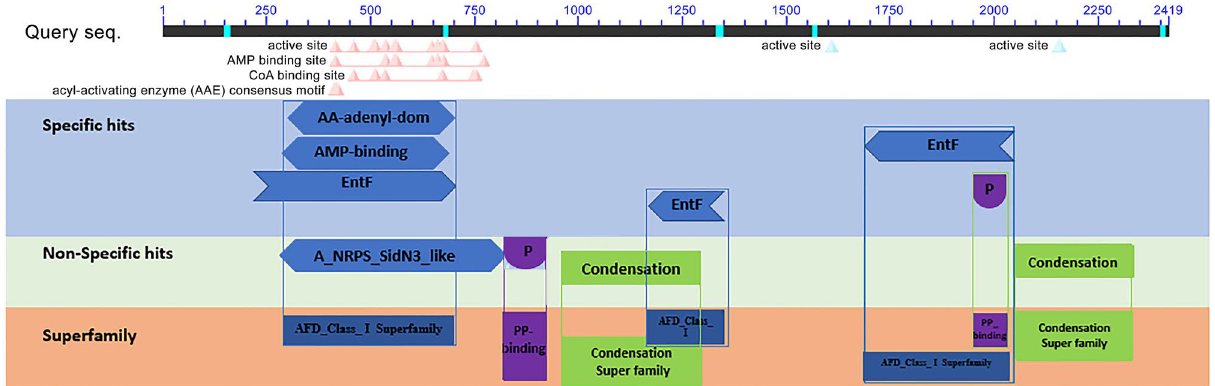
Figure 1. Conserved domains on predicted protein sequence using NCBI Conserved Domain Search 65 . Protein classification: AMP-binding and AA-adenyl-domain belong to adenylation domain, A_NRPS_SidN3_Like is the adenylation A domain of siderophore-synthesizing NRPS 37 , EntF is a NRPS synthetase component F that is responsible for secondary metabolites biosynthesis, catabolism and transport 85 . PP_binding (phosphopantetheine attachment site) is a 4 ′ -phosphopantetheine prosthetic group is linked by a serine. The role of this prosthetic group as a ‘swinging arm’ for the connection of activated fatty acid and amino-acid groups to Condensation domain 29 . Condensation catalyzes a condensation process to form peptide bonds in NRP biosynthesis 86 . AFD_Class_I superfamily, Condensation superfamily, pp-binding